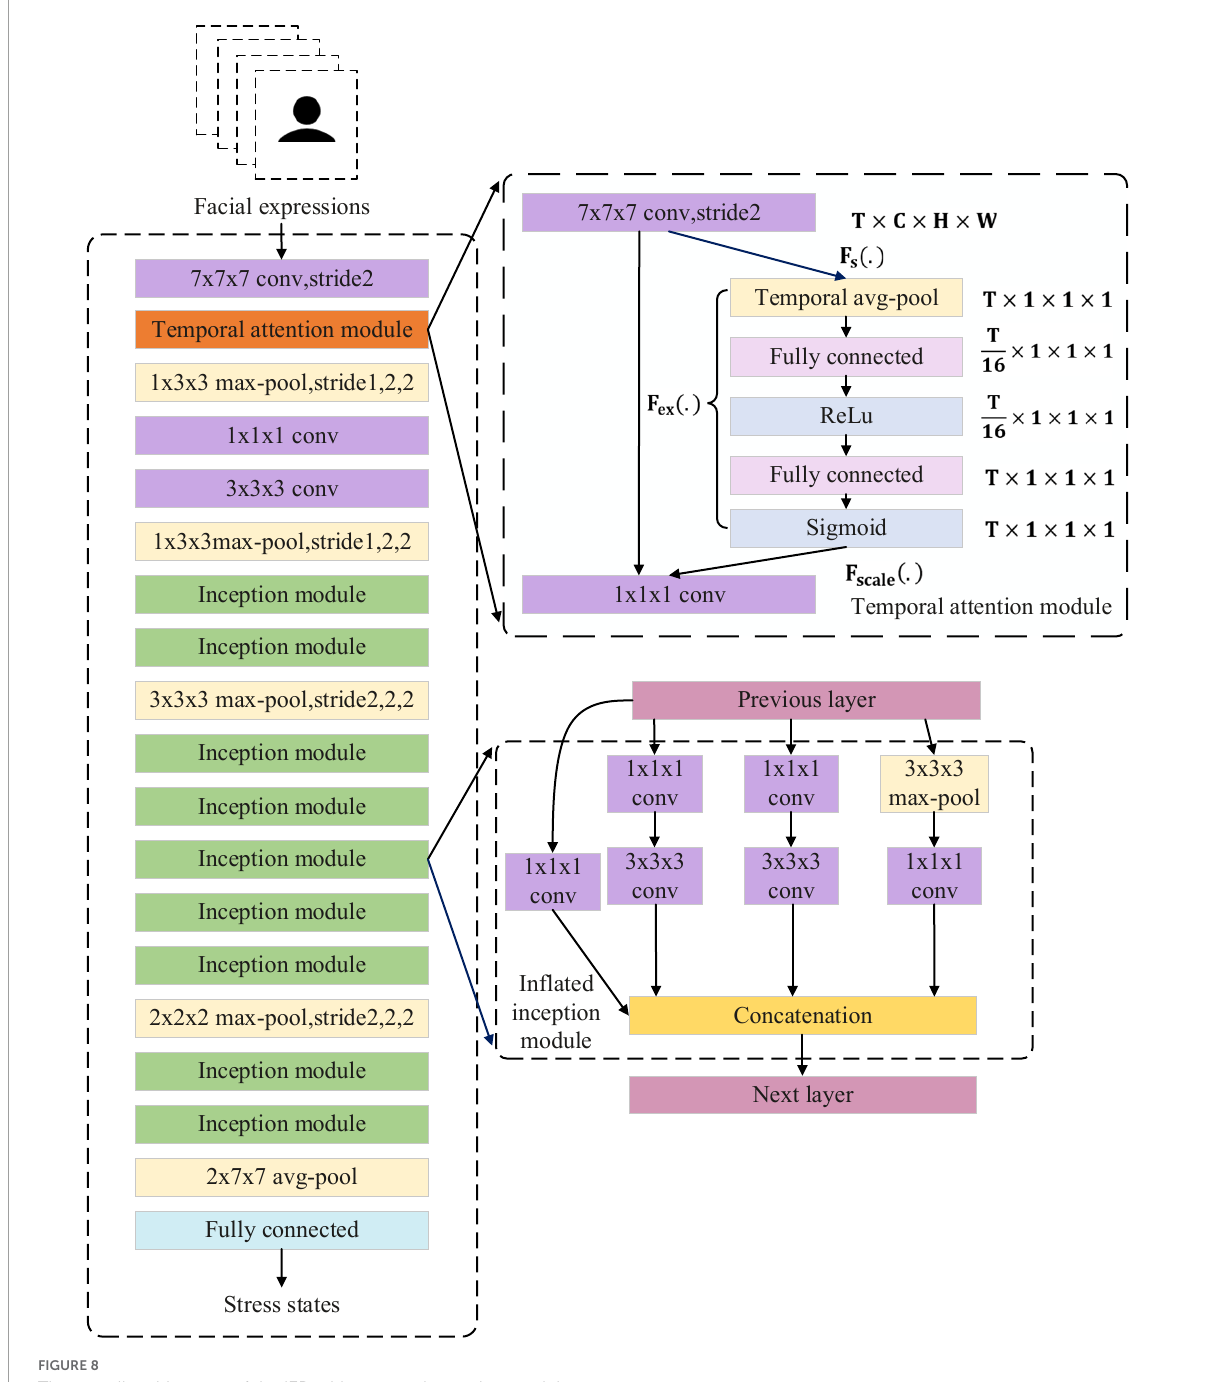
FIGURE8 The overall architecture of the I3D with temporal attention